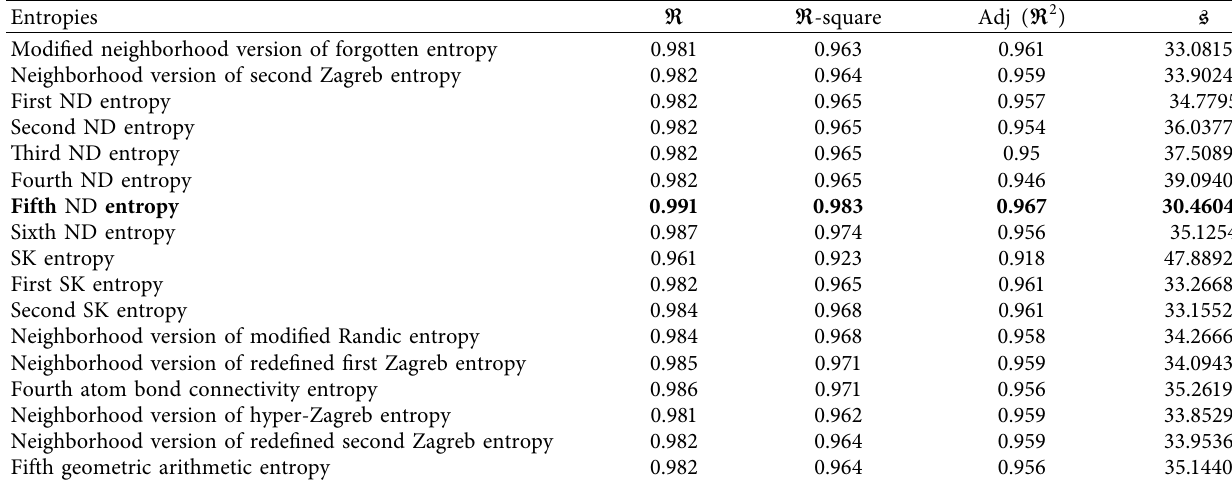
Table 6: The significant LRM: critical volume of benzene derivatives on indices.